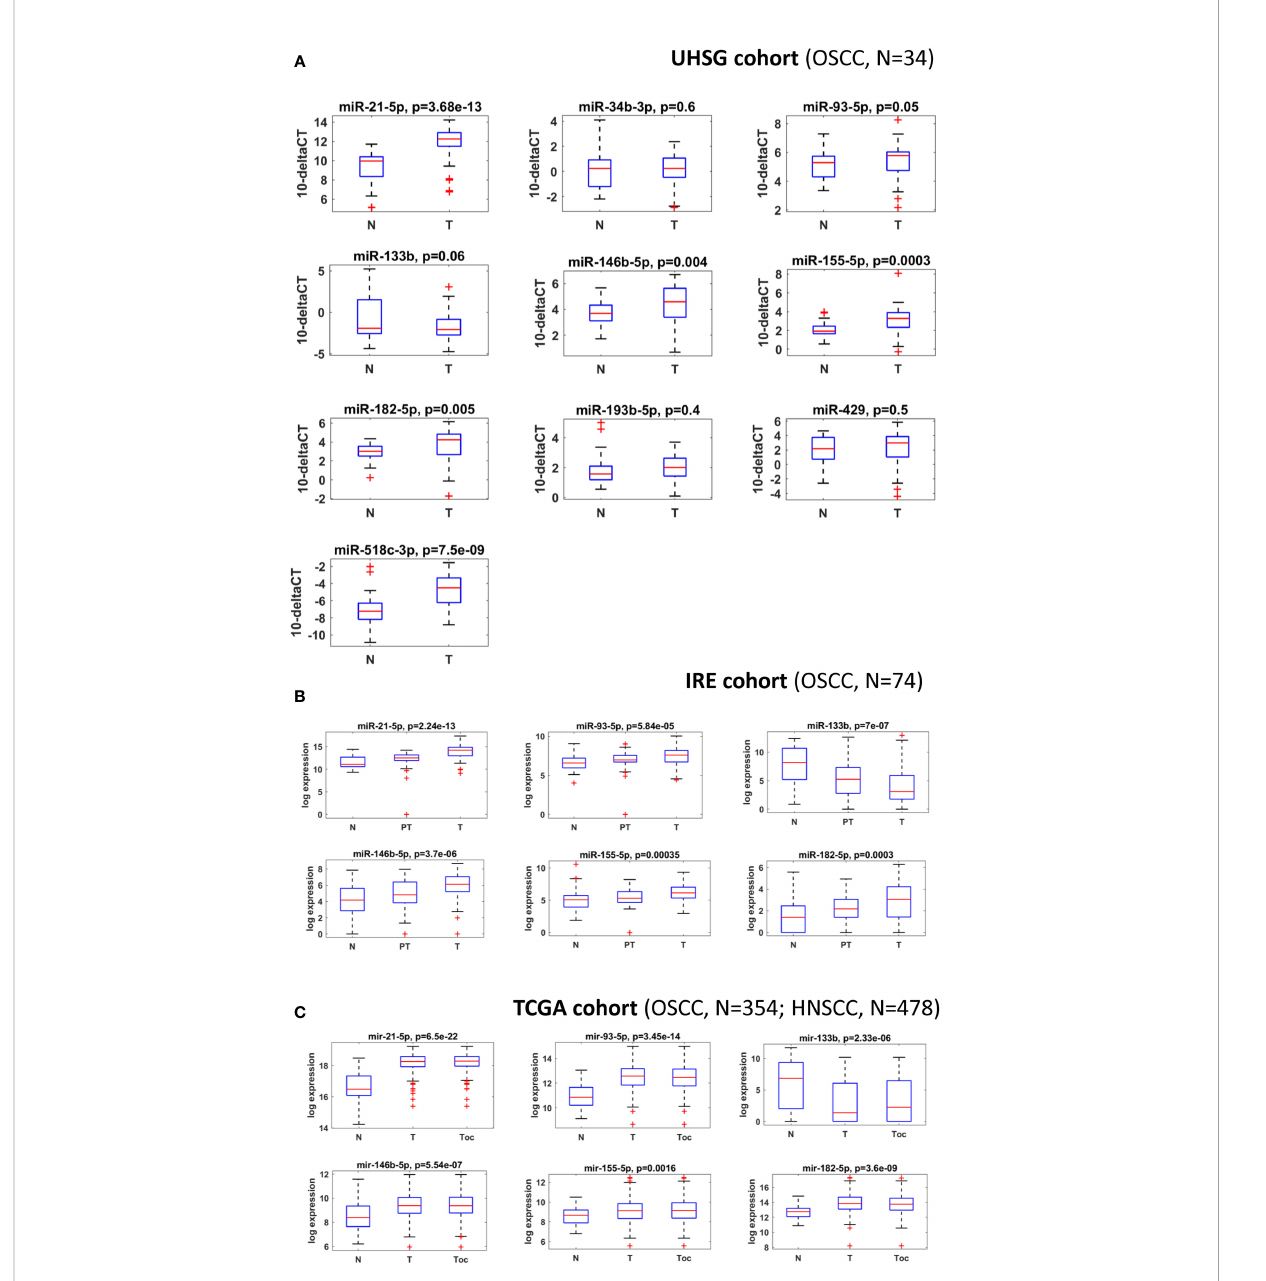
FIGURE 2 miR-21-5p, miR-93-5p, miR-146b-5p, miR-155-5p, miR-182-5p and miR-133b are differentially expressed in three different OSCC patient cohorts. (A) Box plots of the normalized delta Ct expression of a 10 miRNA panel, evaluated in both OSCC and normal tissues from the UHSG cohort. Expression levels were determined by RT-qPCR and presented as fold differences. The reference control genes RNAU6 and SNORD72 were measured with two replicates in each PCR run, and the average Ct value was used for relative expression analysis. Relative miRNA abundance was calculated using the comparative 2 - DD Ct method and normalized to geomean of the reference gene levels. Data are summarized from two technical replicates for each patient. N=normal, T=Tumoral. (B) Box plot showing the expression levels of miR-21-5p, miR-93-5p, miR-146b-5p, miR-155-5p, miR-182-5p, and miR-133b in normal, peritumoral and tumoral OSCC tissues from IRE cohort. N=normal, PT=Periumoral T=Tumoral. (C) Box plots showing expression levels of miR-21-5p, miR-93-5p, miR-146b-5p, miR-155-5p, miR-182-5p, and miR-133b in the tumoral and normal OSCC tissues from the TCGA cohort. P ≤ 0.05 was considered statistically signi fi cant for all assays. N=normal, T=HNSCC, Toc=